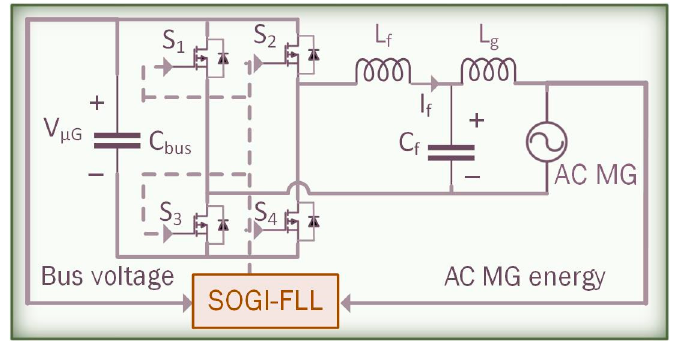
Figure 13. Control for DC–AC converter working as an inverter.